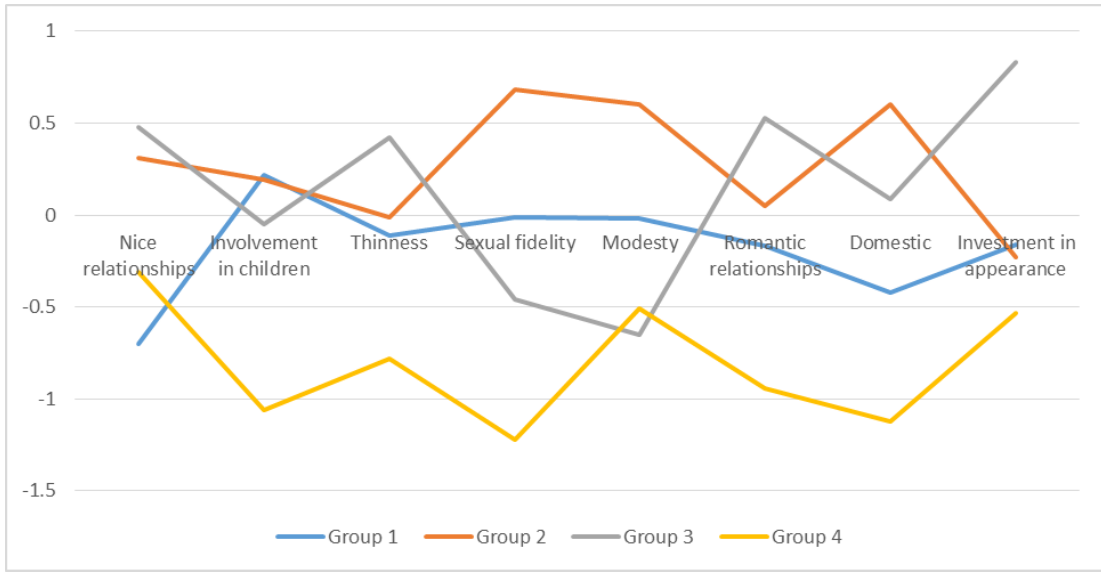
Figure 1. Patterns of feminine role conformity (* standardized scores).